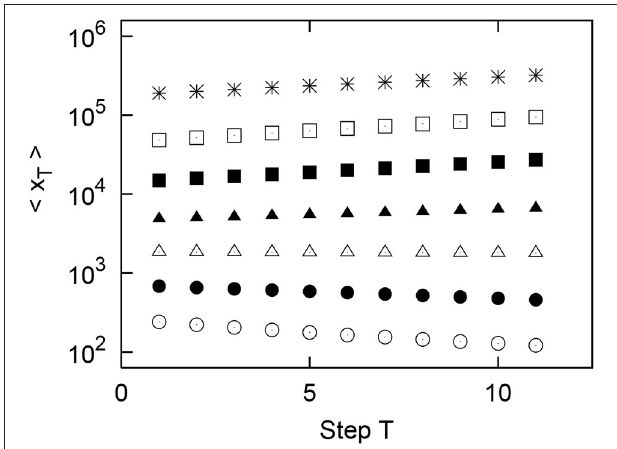
FIGURE 14 | The m dependence of the exponent β IT ( m ) when the T dependence of the geometric mean h x T i is approximated by an exponential function e β IT ( m ) T in a Italy simulation ( Figure 12 ). The errors are so small that they do not appear in the figure, and they are therefore omitted.